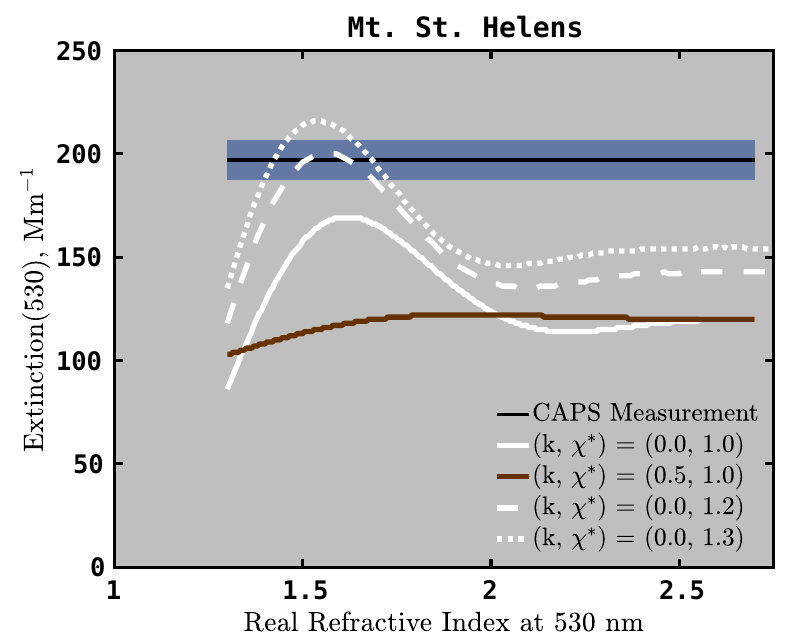
Figure 7. Measured (black line) and computed extinctions of the Mt. St. Helens PM 1 sample; shaded region covers ± 5% of measured value. Mie theory computations of volume equivalent sizes (white and brown lines) were processed using the measured aerodynamic size distribution, measured density (2.48 g-cm − 3 ), and a wide range of real refractive indices. Each computed line has a specific imaginary refractive index (k) and dynamic shape factor ( χ ∗ ) as noted in the legend. Intersections of computed white lines with the measured extinction line indicate that χ ∗ ≥